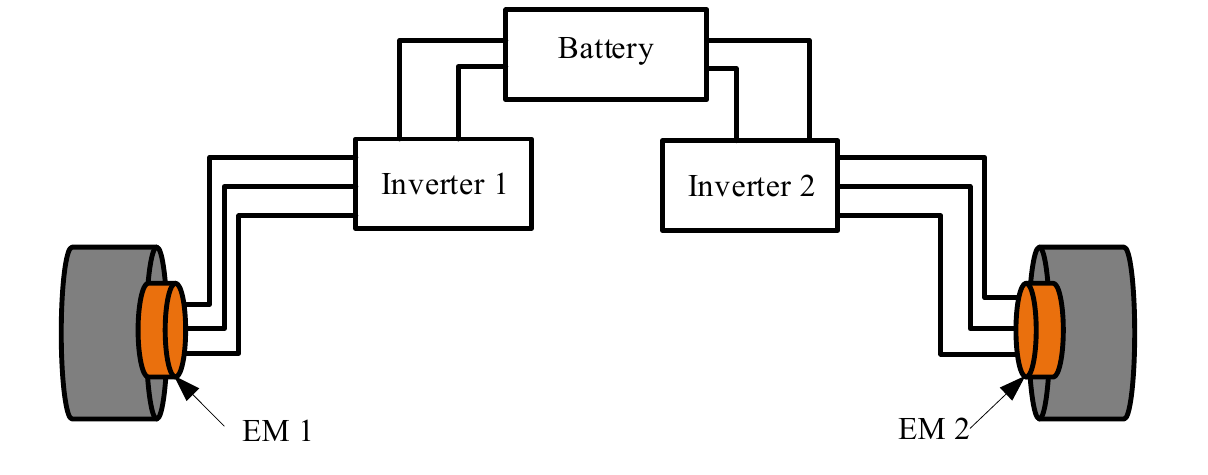
Figure 11. In-wheel motor